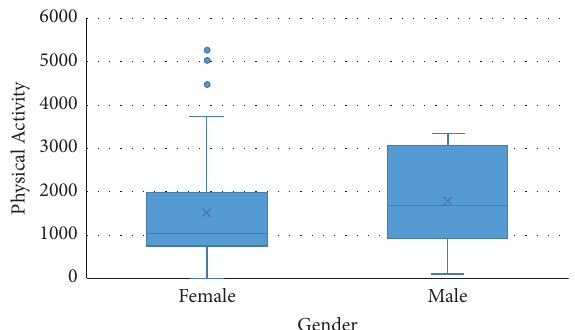
Figure 4: Relationship between gender and physical